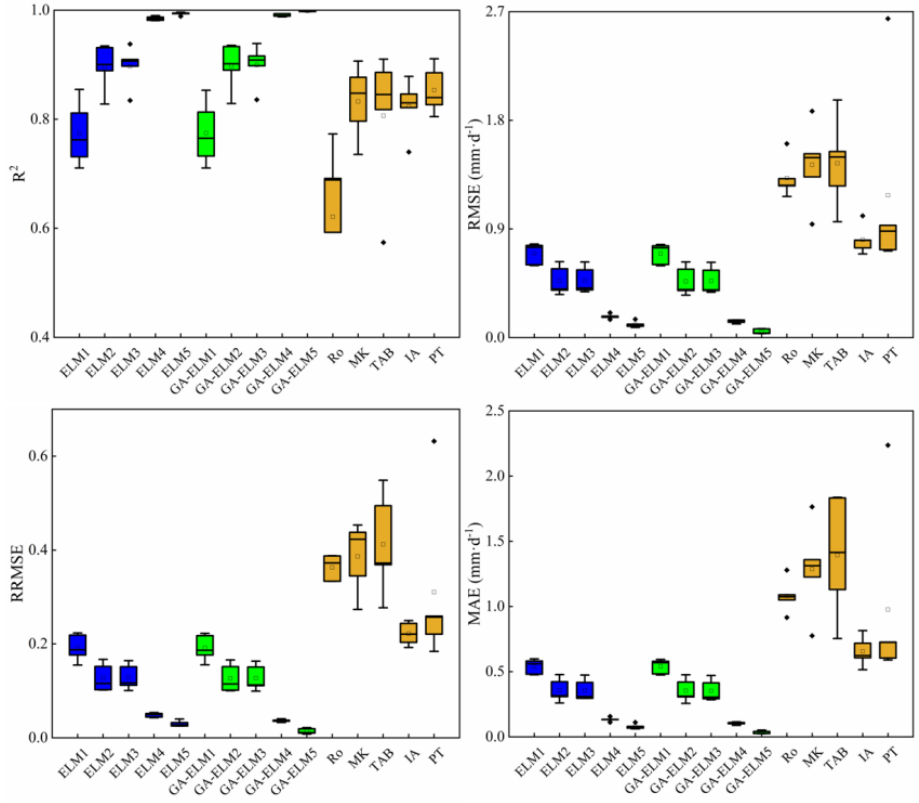
Figure 5. Boxplots of statistical indicators for each daily ET 0 prediction model in Southwest China. Blue: ELM models; green: GA-ELM models; yellow: empirical models.